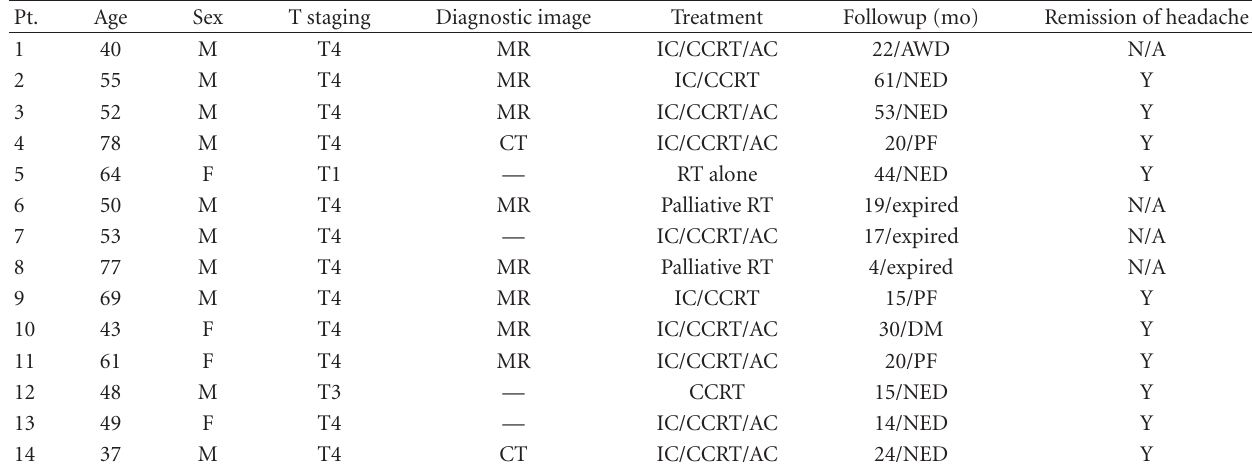
Table 1: Characteristics of NPC patients with headache as the initial presentation.